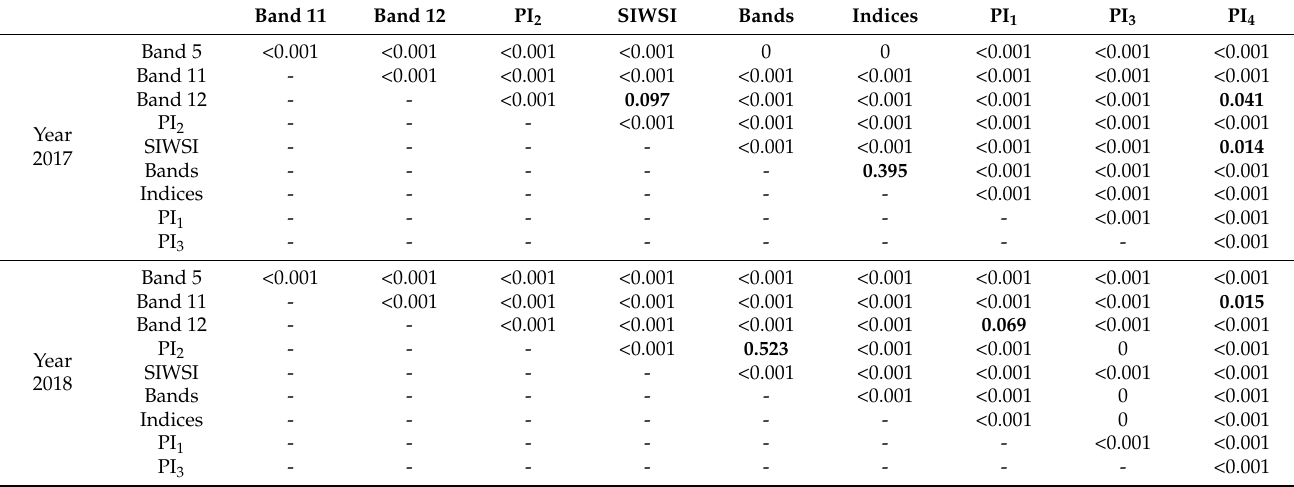
Table A3. Classification comparison with the p -values derived from the McNemar significance test of performance on the test set. Values less than the significance level of α = 0.05 indicate a statistically significant difference between the two models at the 95% confidence interval. Otherwise, if the p -values > α (highlighted in bold), the null hypothesis cannot be